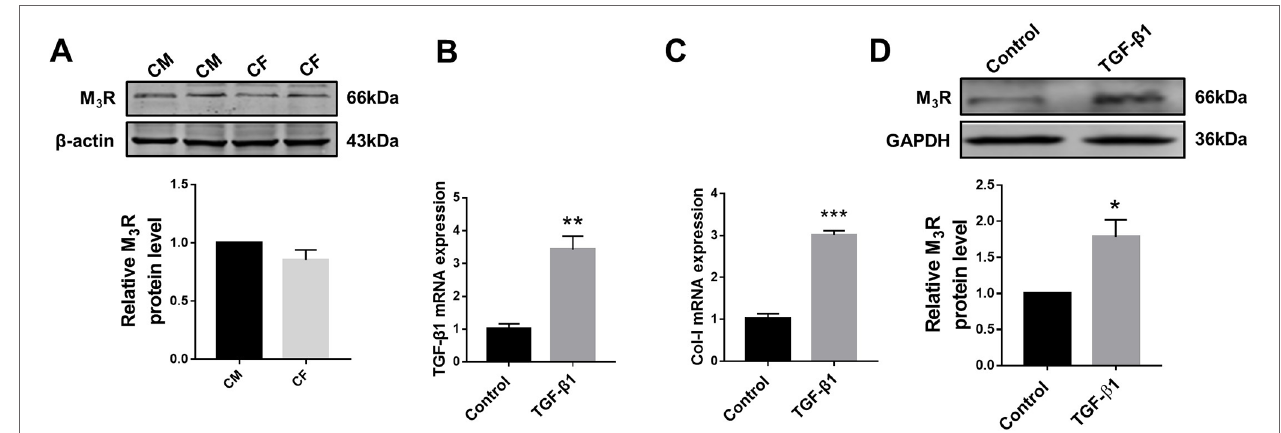
FIgURe 1 | Protein level of M3 muscarinic acetylcholine receptor (M3R) in transforming growth factor beta 1 (TGF-β1)-induced cardiac fibroblasts (CF). (A) Protein level of M3R in CF and cardiomyocytes (CM). n = 3. (B) Effect of TGF-β1 (20 ng/ml, 48 h) on messenger RNA level of TGF-β1. ** p < 0.01 vs. Ctrl, n = 3. (C) Effect of TGF-β1 (20 ng/ml, 48 h) on mRNA level of collagen I. *** p < 0.001 vs. Ctrl, n = 3. (D) Effect of TGF-β1 (20 ng/ml, 48 h) on protein level of M 3 R in CF. * p < 0.05 vs. Ctrl, n = 4.